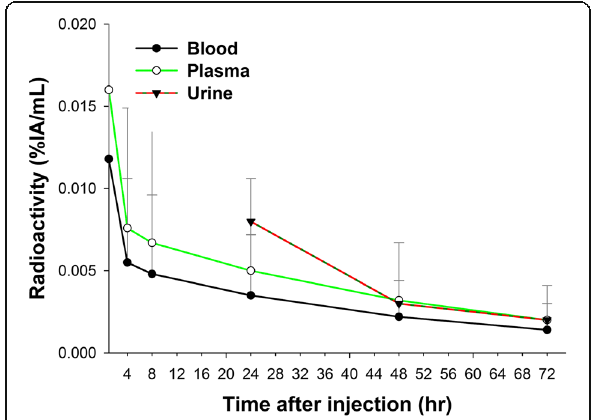
Fig. 1 Blood, plasma, and urine clearance for nano-carrier 188 Re-liposome in patients. The radioactivity that is measured in whole blood samples is identical to that in the plasma after centrifugation